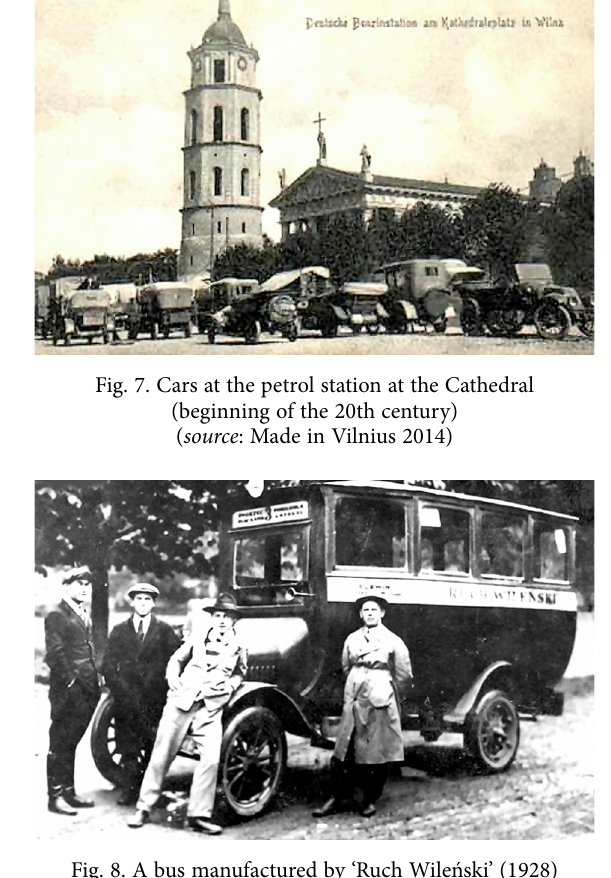
Fig. 8. A bus manufactured by ‘Ruch Wileński’